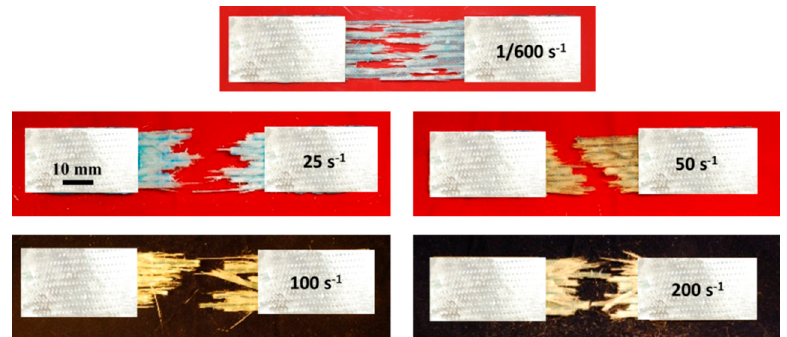
Figure 9. Fracture morphologies of GFRP under different strain rates.